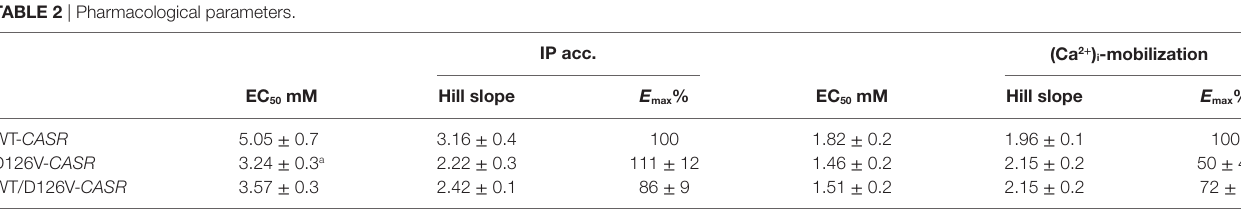
Table 2 | Pharmacological parameters.